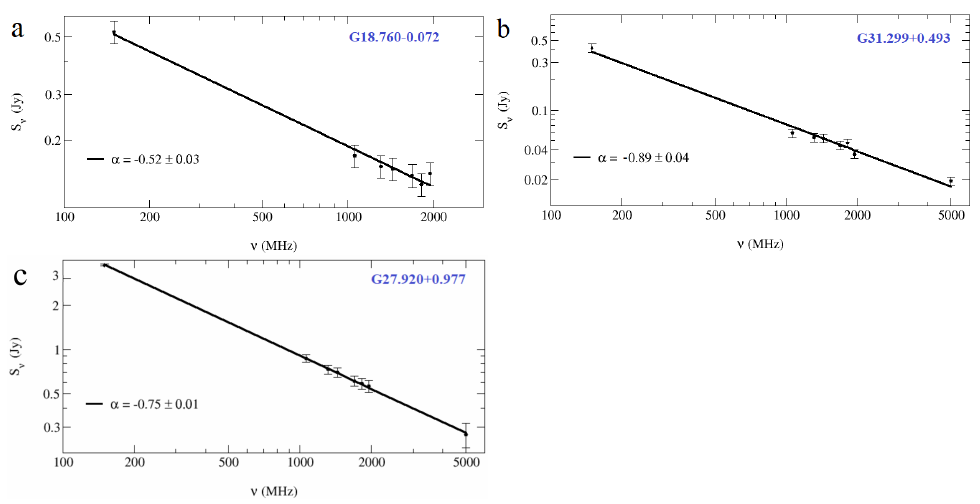
Figure 7. Continuum spectra for ( a ) SNR G18.760 − 0.072; ( b ) SNR G31.299 − 0.493; ( c ) G27.920 + 0.977; 150 MHz flux densities are obtained from the archival TGSS data; the flux densities between 1 and 2 GHz are from the THOR survey, and the 5 GHz data are from CORNISH and